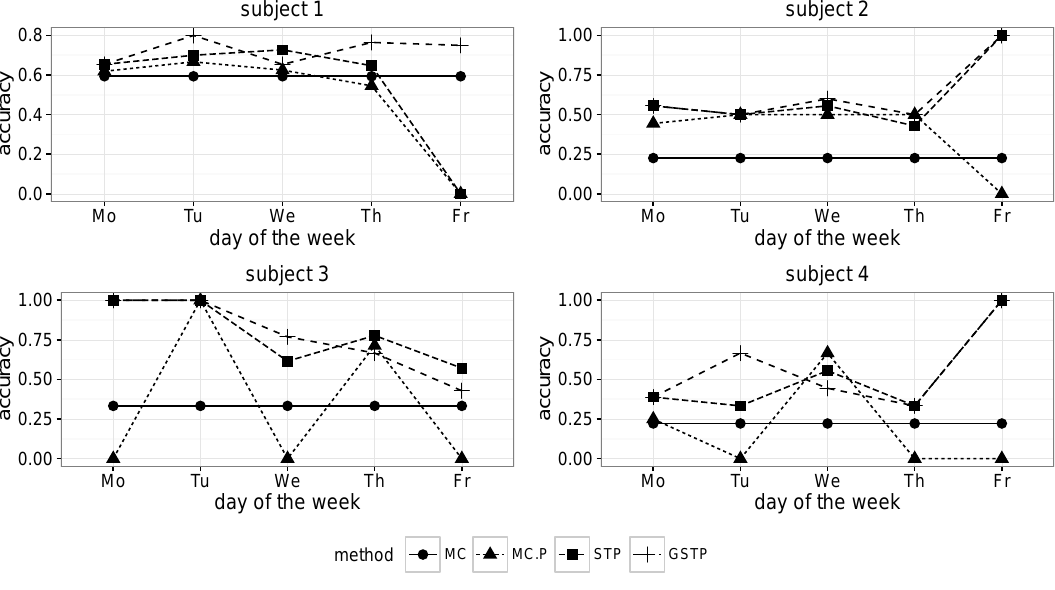
Figure 6. Accuracy results across the days of the week for Subjects 1 to 4. MC, Markov chain; P, periodicity.